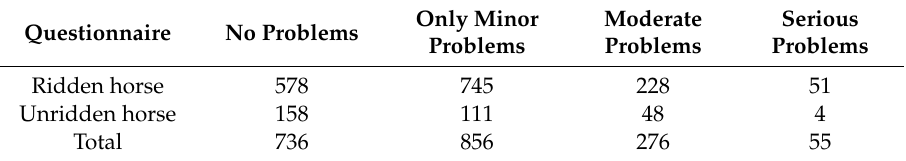
Table 1. The number of respondents reporting behavioural problems in each category. A total of 1923 respondents were asked whether “you have been experiencing problems with your horse’s behaviour in the last six months?”.